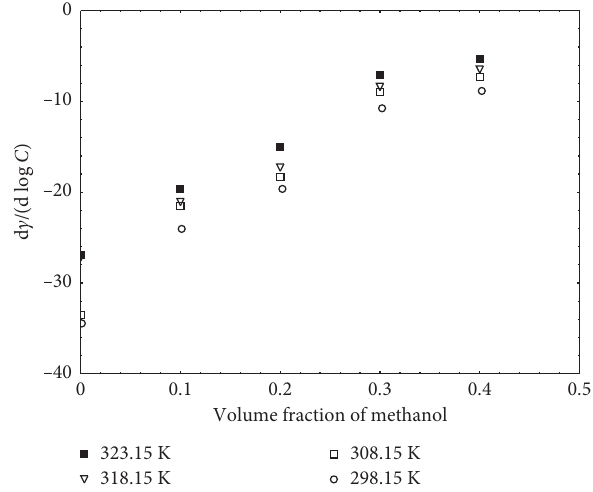
Figure 3: Variation in slope d c /dlog C with volume fractions of methanol for CTAB solutions.